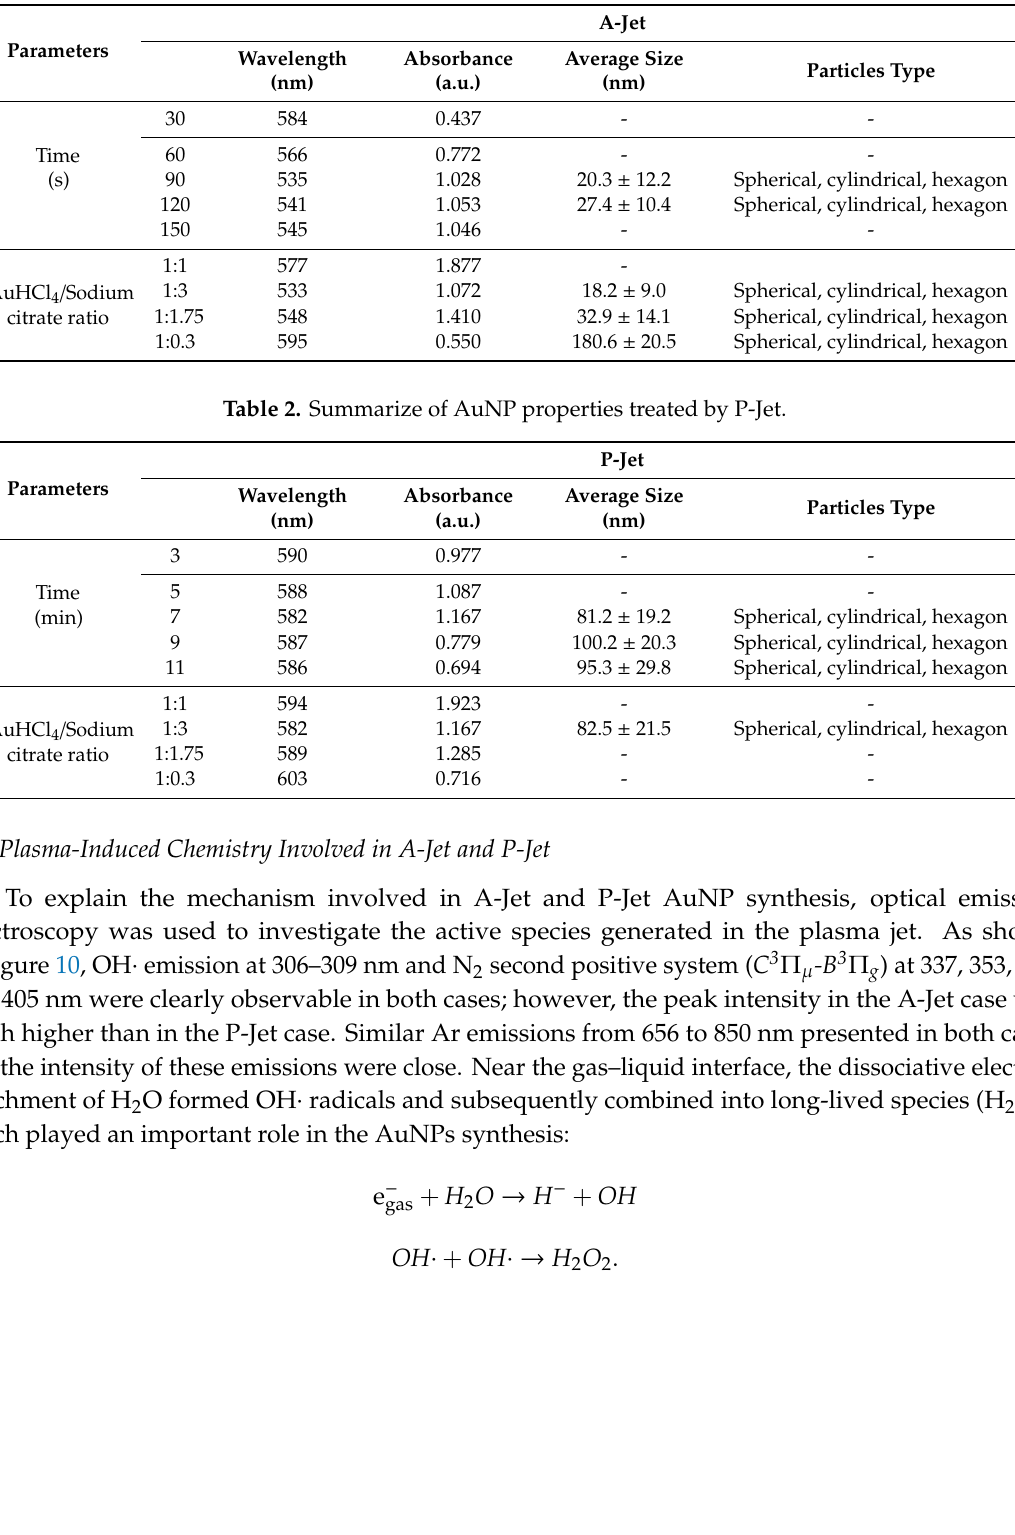
Table 1. Summarize of AuNP properties treated by A-Jet.